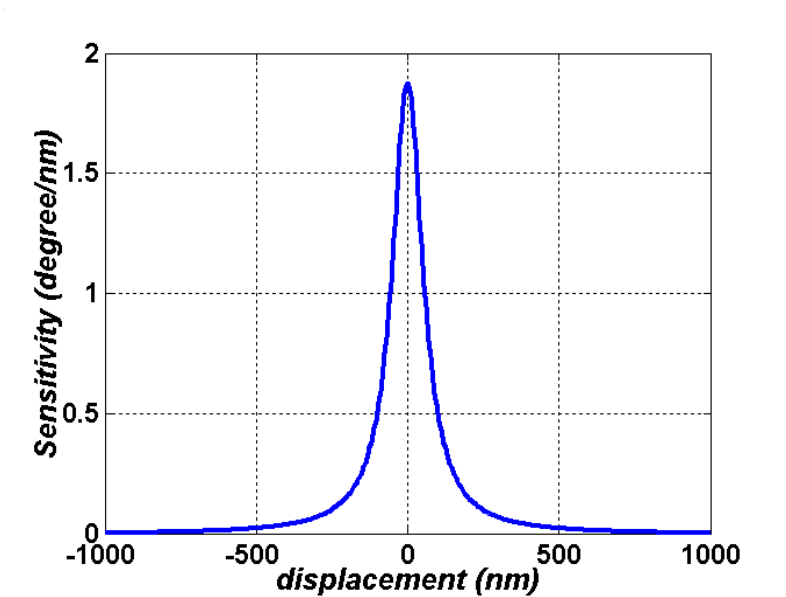
Figure 8. The sensitivity S versus